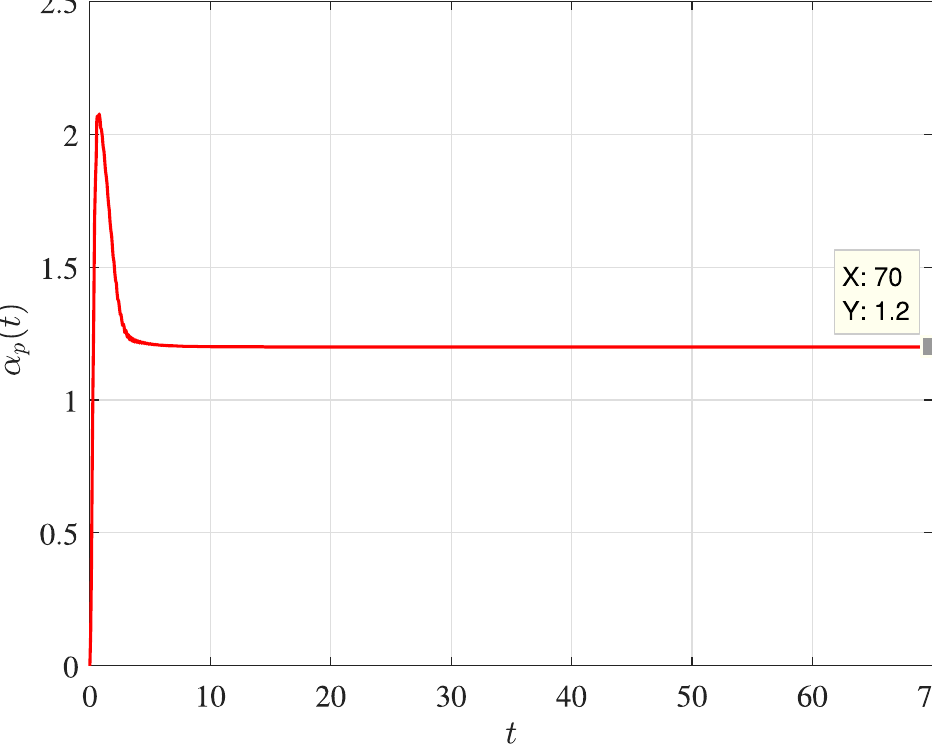
Figure A1. Estimation of the load-correcting factor over time.